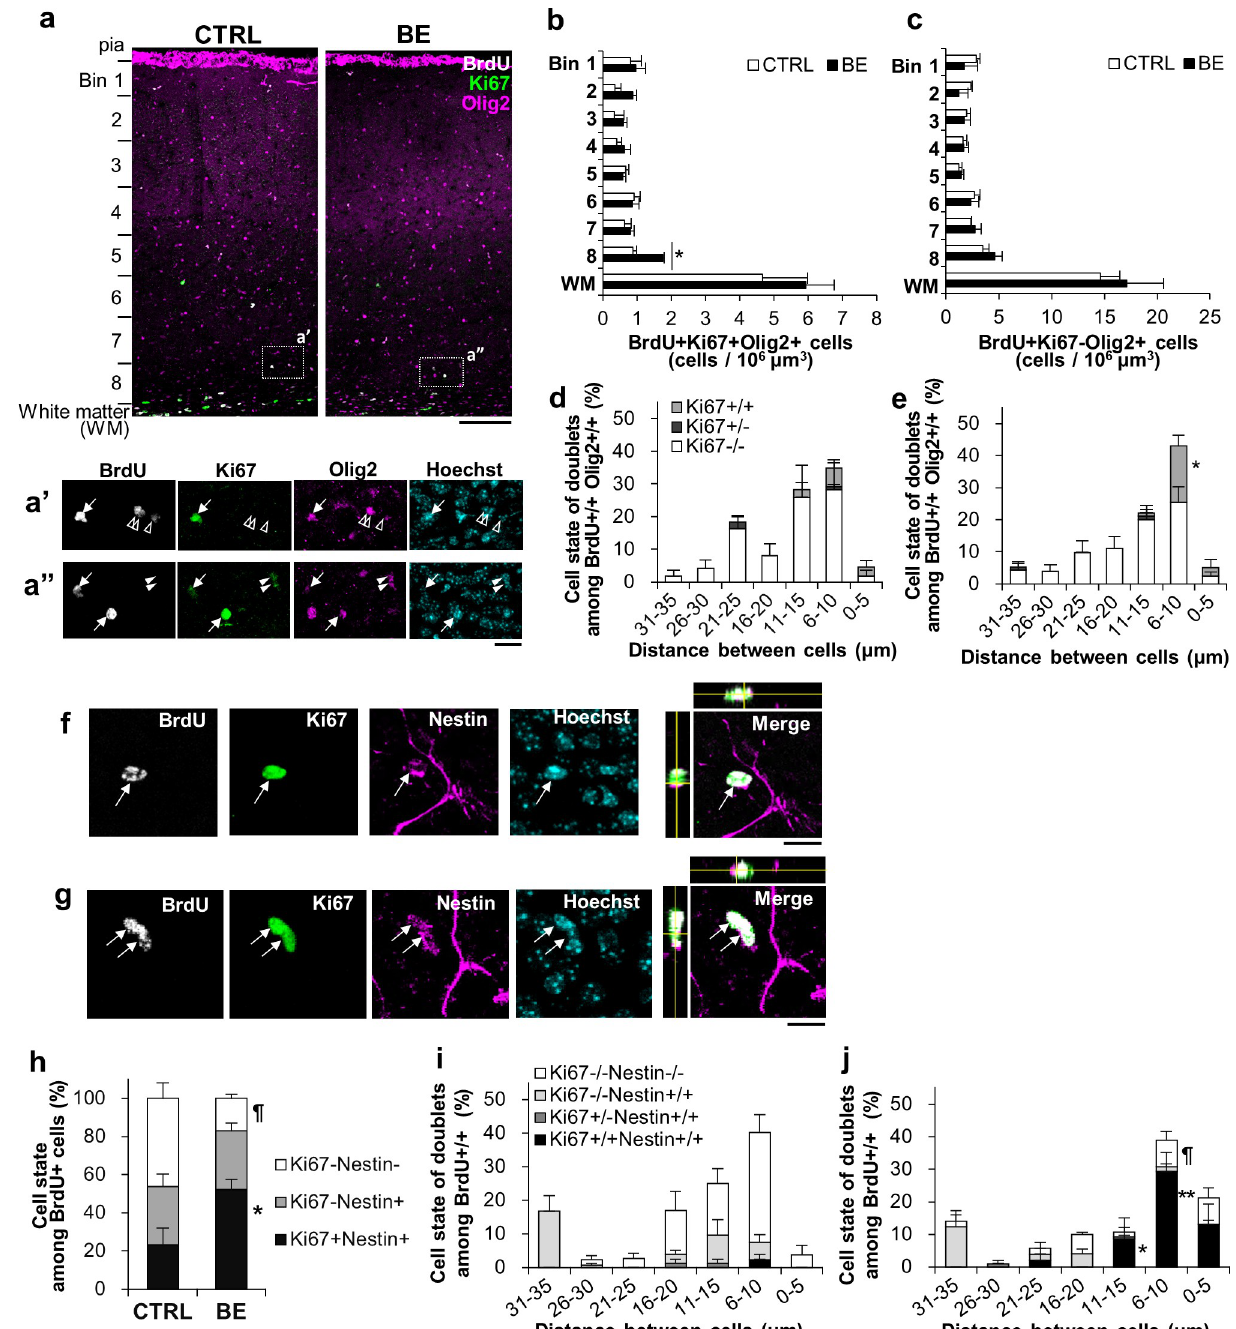
Fig 3. Cell state and cell division symmetry at P25. ( a-c) Laminar analysis of BrdU+ (gray), Ki67+ (green), and Olig2+ (magenta) cells in V1. Boxed areas were magnified below ( a’ and a” ), showing BrdU+Ki67+Olig2+ cells (arrow), BrdU+Ki67-Olig2+ cells (open arrowhead), and BrdU-Ki67+Olig2 + cells (closed arrowhead). Scale bars, 100 μ m ( a ), 20 μ m ( a’ , a” ). The laminar cell densities of Ki67+ proliferative state ( b ) and Ki67- ( c ) OL lineage cells. N = 5 per group, one-way ANOVA, F(1, 8) = 51.91, � p = 0.000092. ( d , e ) Cell state analysis of BrdU+Olig2+ sister cells in bin 8 based on Ki67 expression. Symmetrically proliferative cells (Ki67+/+), proliferative and differentiated asymmetric doublets (Ki67+/-), and symmetrically differentiated cells (Ki67-/-) were compared between control ( d ) and BE ( e ) mice at each distance range using one-way ANOVA with Tukey-Kramer post hoc test: F(1, 8) = 7.94, � p = 0.023, N = 5 for each mouse group. ( f-j ) Cell state analysis of BrdU+ (gray) proliferated cells using Ki67 (green) and Nestin (magenta) in bin 8 of control ( f ) and BE ( g ) mice. Ki67+Nestin+ (arrow) among BrdU+ cells. The x-z and y-z cross-section views of white box images are shown at the top and left of the box, respectively. Scale bars, 20 μ m. ( h ) Proportion of BrdU+ singlet cells expressing Ki67 and/or Nestin. N = 5 for each mouse group, one- way ANOVA with Tukey-Kramer post hoc test, F(1, 8) = 8.31, � p = 0.020 for Ki67+Nestin+, F(1, 8) = 12.41, ¶p = 0.0078 for Ki67-Nestin-. ( i , j ) Cell state